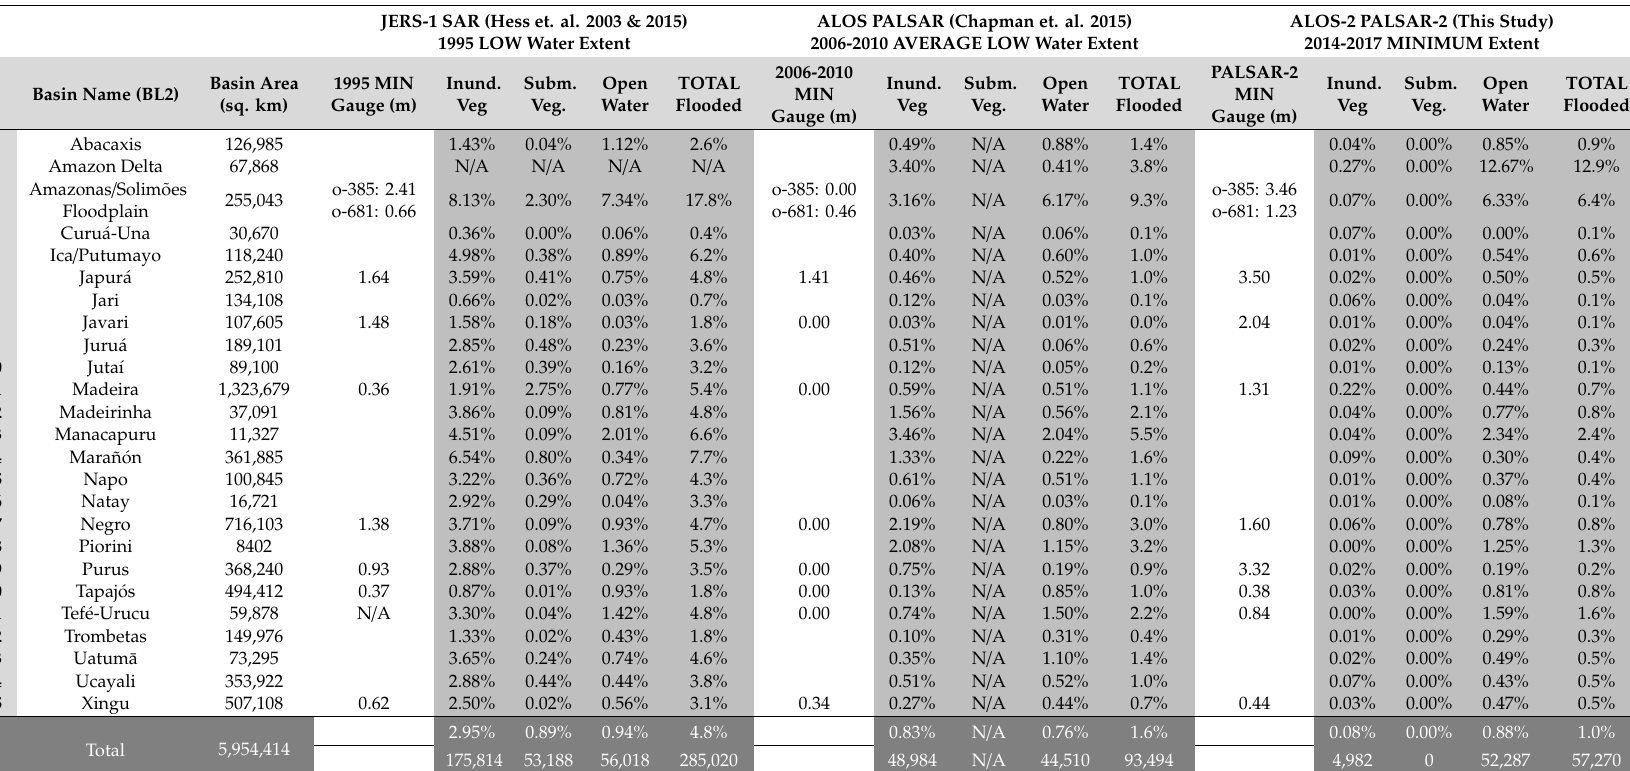
Table 5. Comparison of Amazon Basin low water / minimum inundation maps 1995–2017 by Hess et al. [8,9], Chapman et al. [11] and this